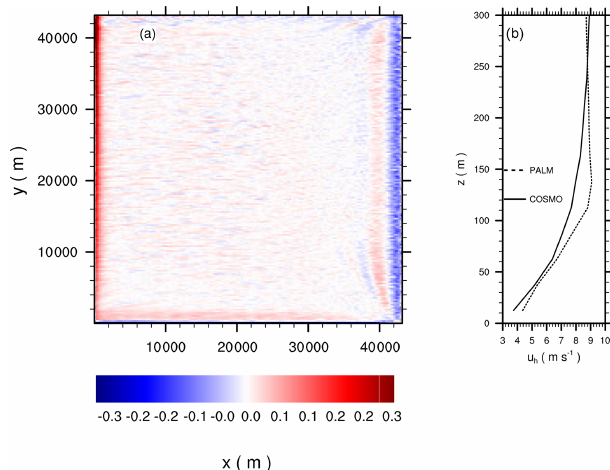
Figure 19. Horizontal cross-section of 30min time-averaged (a) vertical velocity component at 03:00UTC at z = 100m. In addi- tion, panel (b) shows corresponding vertical profiles of the hori- zontal wind speed averaged over a 10 × 10km area located at the domain centre, as well as the lateral inflow profile from the COSMO solution. The wind blows from the east.